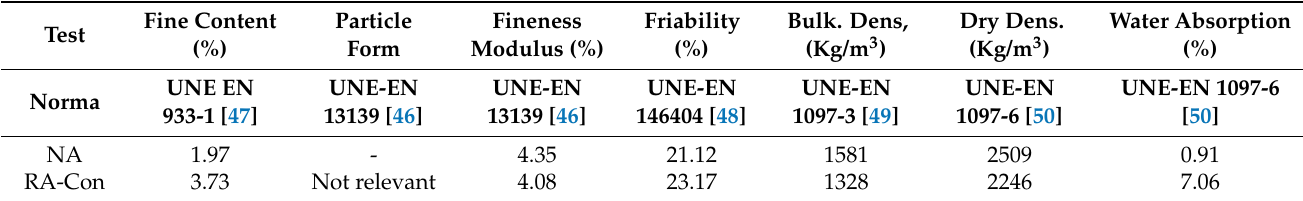
Table 2. Physical characterization of the aggregates used.